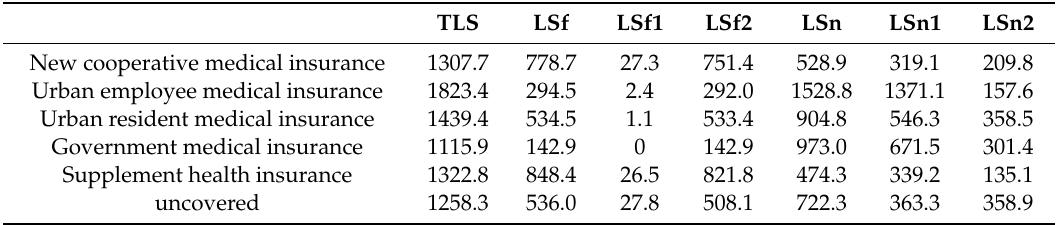
Table 5. Di ff erent types of health insurance coverage and labor supply time (hours /